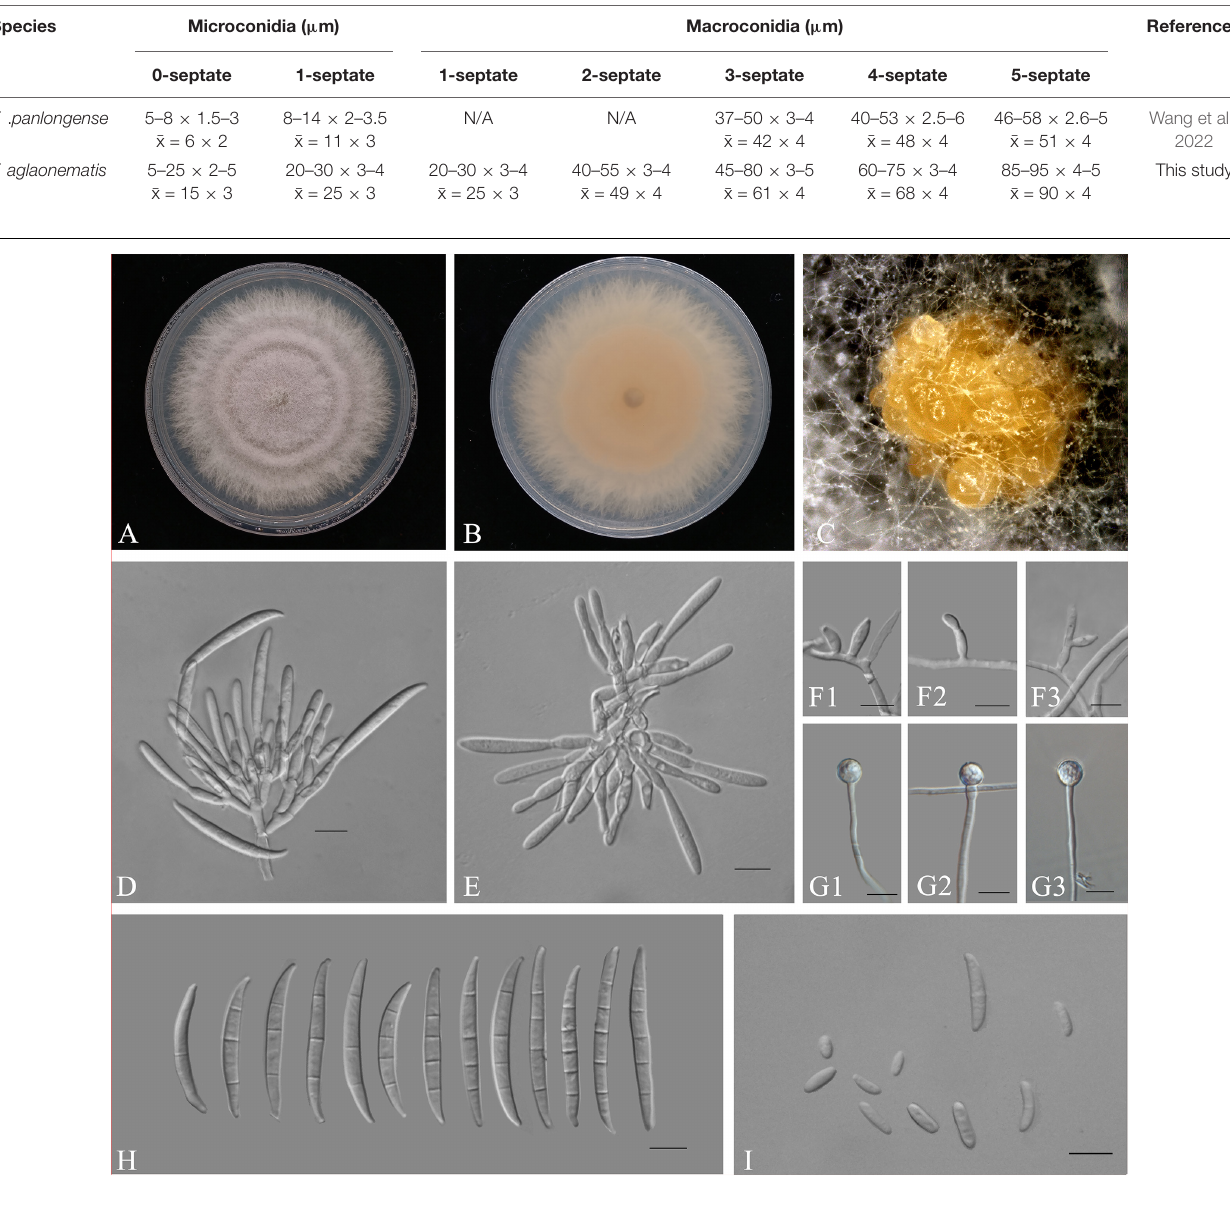
FIGURE 5 | Fusarium elaeidis (ZHKUCC 22-0080). (A,B) Culture characteristics on PDA after 7 days [ (A) upper view; (B) reverse view]. (C) Sporodochia formed on the surface of carnation leaves. (D,E) Sporodochial conidiophores and phialides. (F1–F3) Aerial conidiophores and phialides. (G1–G3) Chlamydospores. (H) Sporodochial conidia. (I) Aerial conidia. Scale bars: (D–I) = 10 µ